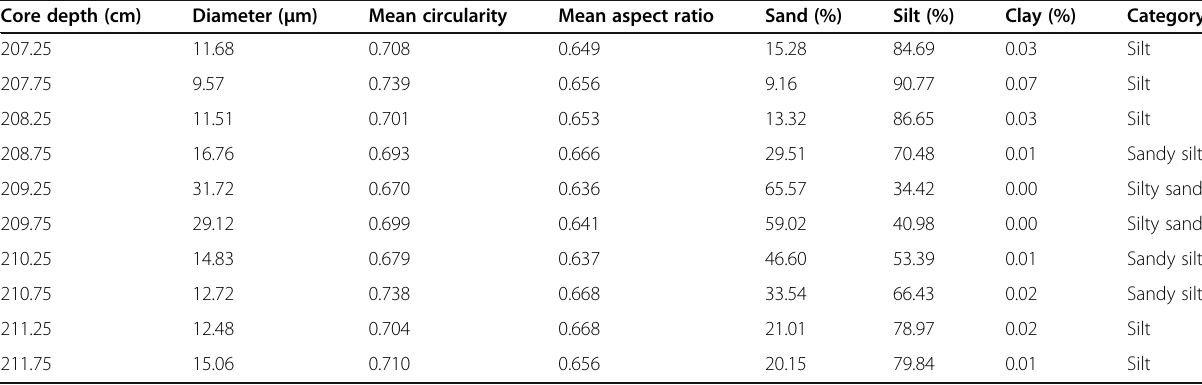
Table 1 Grain size analysis of turbidite T25 in core PC04 Core depth (cm) Diameter ( μ m) Mean circularity Mean aspect